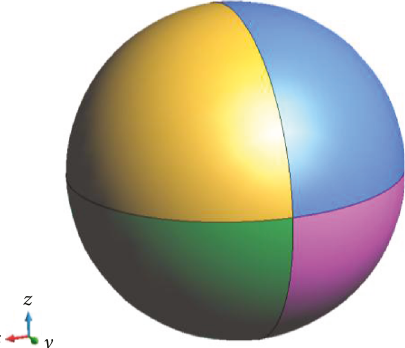
Figure 5: Model of the sphere divided into four parts.